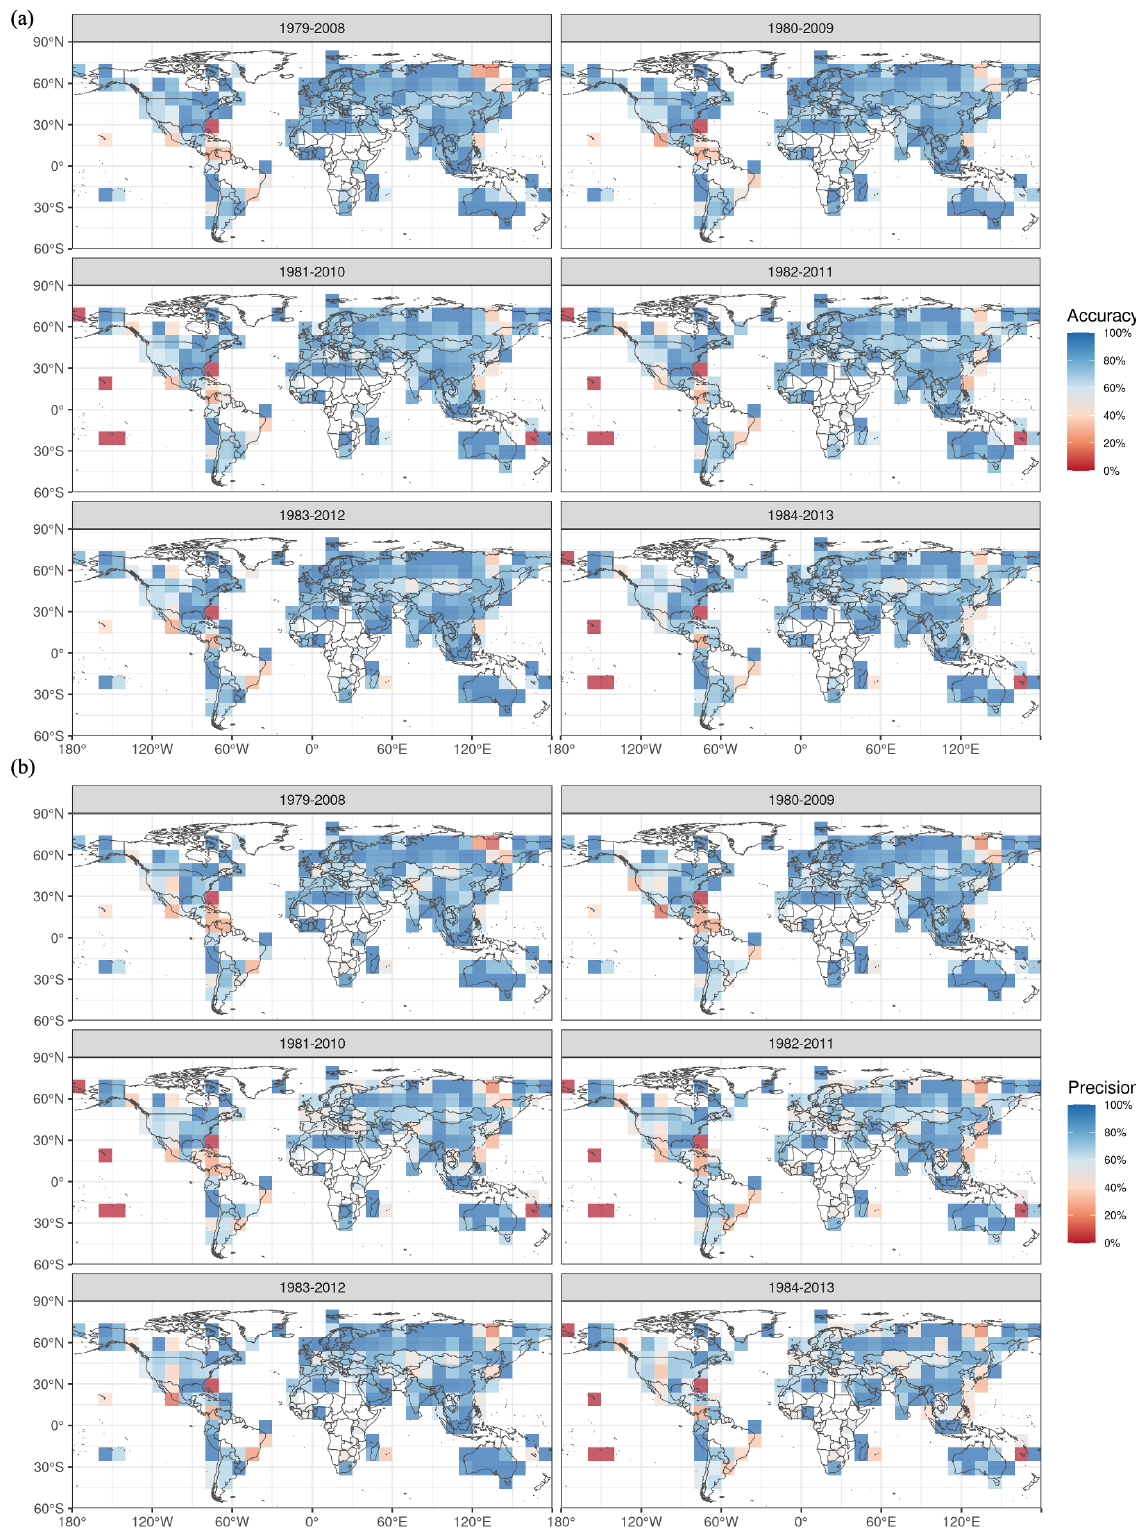
Figure 6. Validation of the historical Köppen–Geiger climate map series (1979–2008, 1980–2009, 1981–2010, 1982–2011, 1983–2012, 1984–2013). (a) Small-scale accuracy of historical Köppen–Geiger climate maps. (b) Small-scale precision of historical Köppen–Geiger climate maps. Climate classification has been applied for each station. The small-scale accuracy and precision are calculated based on the classification results of all the stations within the given region, with a minimum of three stations in the 5 ◦ search radius. Earth Syst. Sci. Data, 13, 5087–5114,